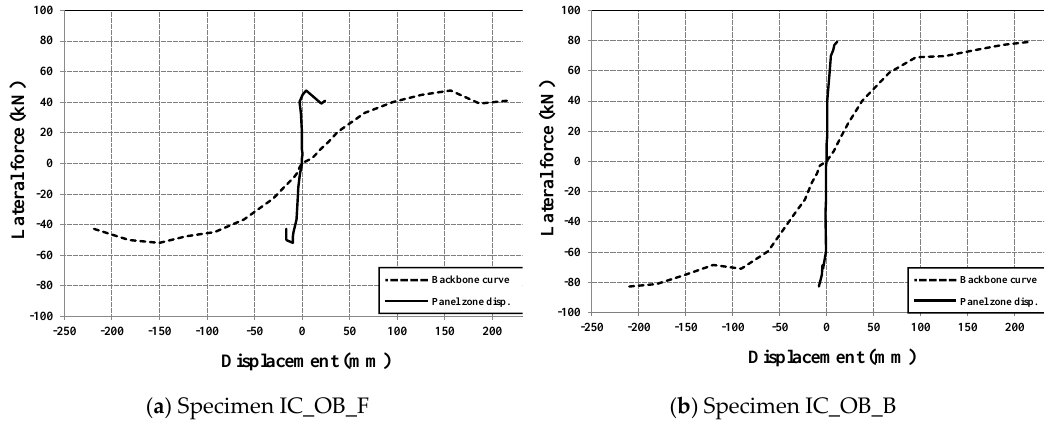
Figure 15. Displacements due to shear deformation of the panel zone connection plate.